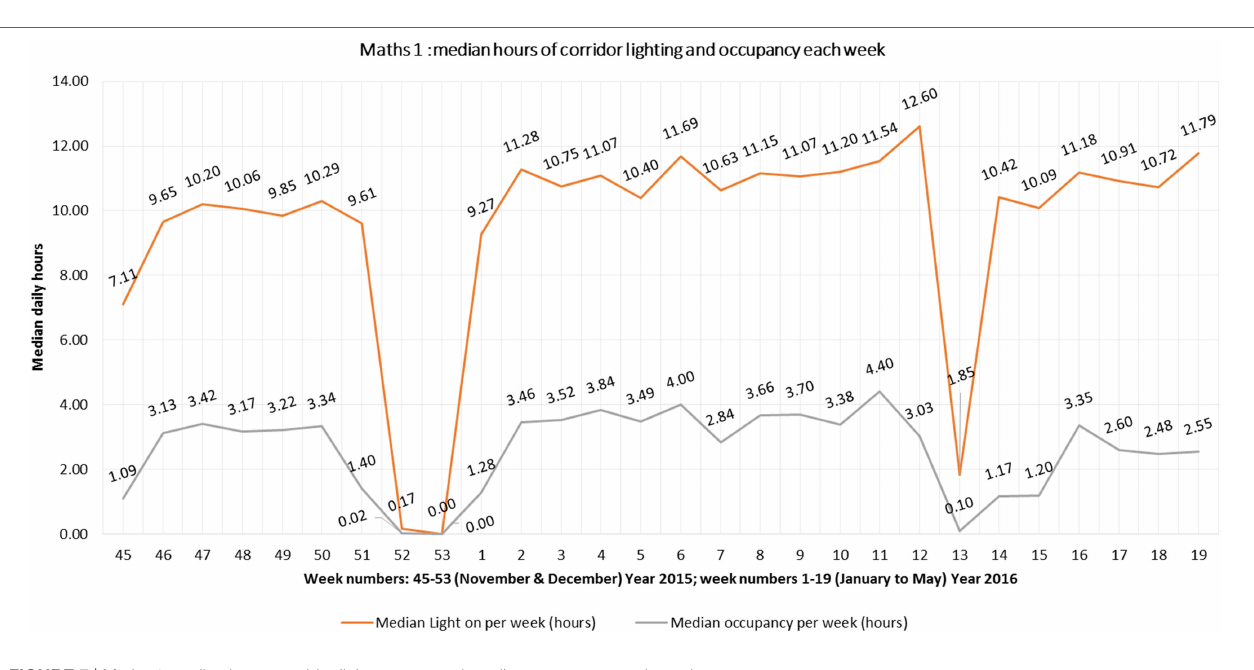
FigUre 7 | Maths 1 median hours corridor lights are on and median occupancy each